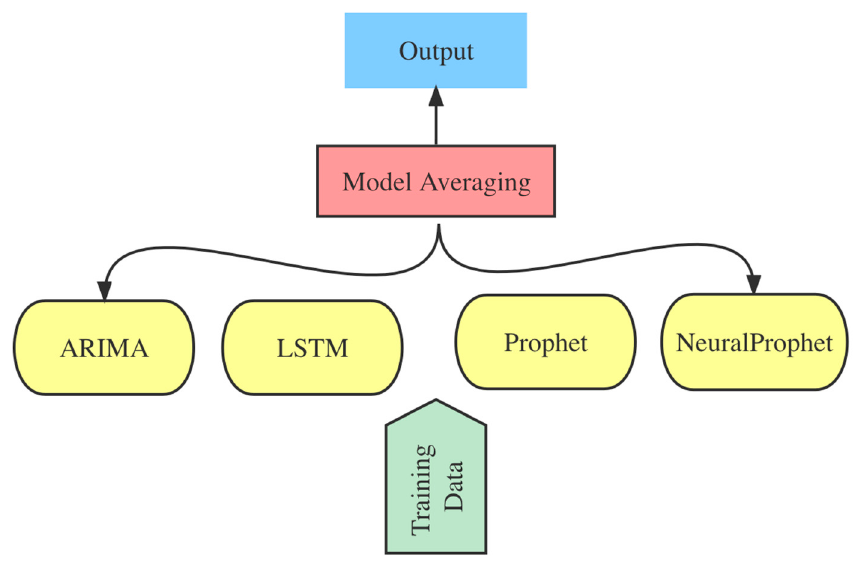
Figure 5. Architecture of the stacking